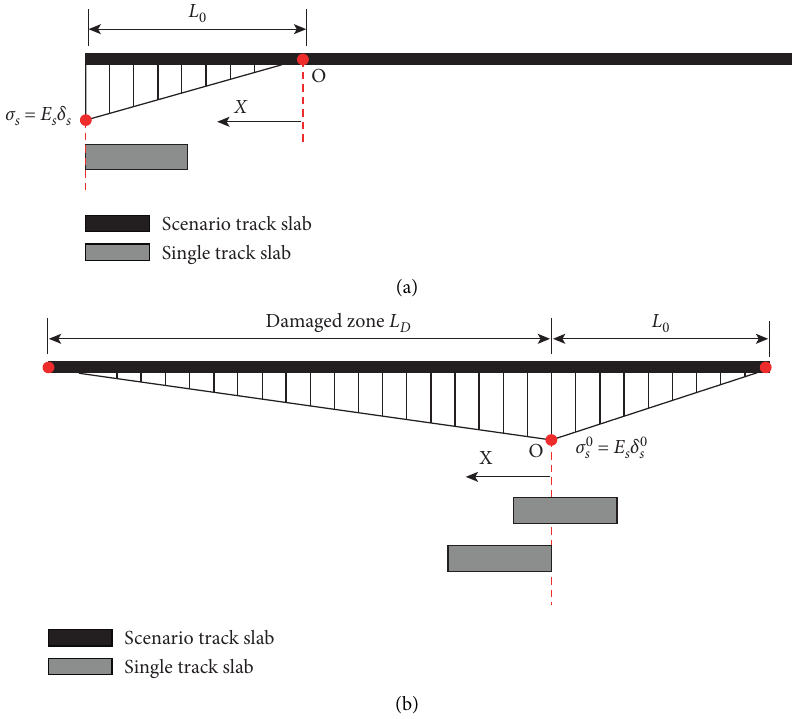
Figure 3: Linear proportional distribution of stress of a single track